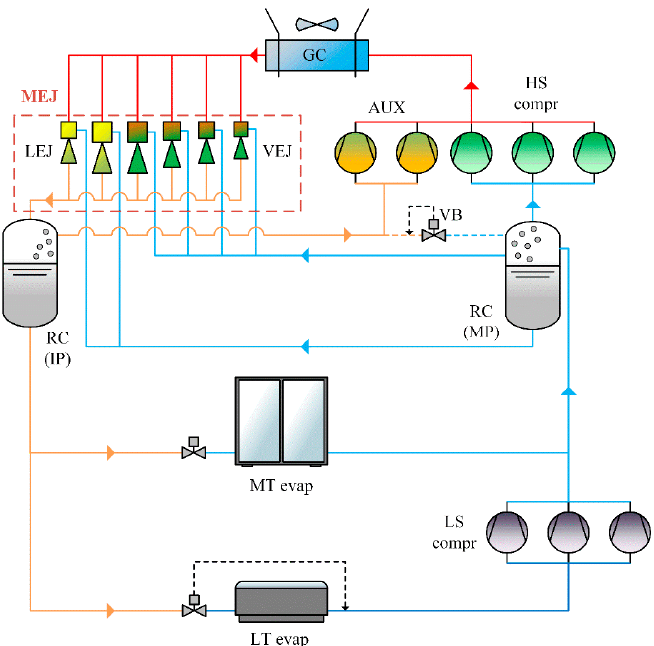
Figure 6. Schematic of a transcritical R744 booster supermarket refrigeration system equipped with multi-ejector block (EJ) (GC: air-cooled R744 gas cooler/condenser; AUX: parallel compressors; HS compr: high stage compressor rack; VB: vapor by-pass valve; MEJ: multi-ejector block; LEJ: liquid ejectors; VEJ: vapor ejectors; RC(IP): receiver at intermediate pressure; RC(MP): receiver at medium pressure; MT evap: evaporates at medium temperature; LT evap: evaporates at low temperature; LS compr: low stage compressor